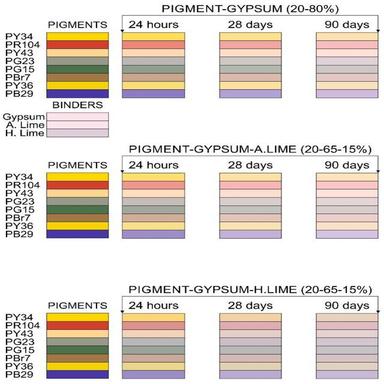
Color chart for the different mixes and inorganic pigments used, indicating their color code and CIELab 1976 chromatic coordinates for the three stages of control (twenty-four hours, twenty-eight days and ninety days).